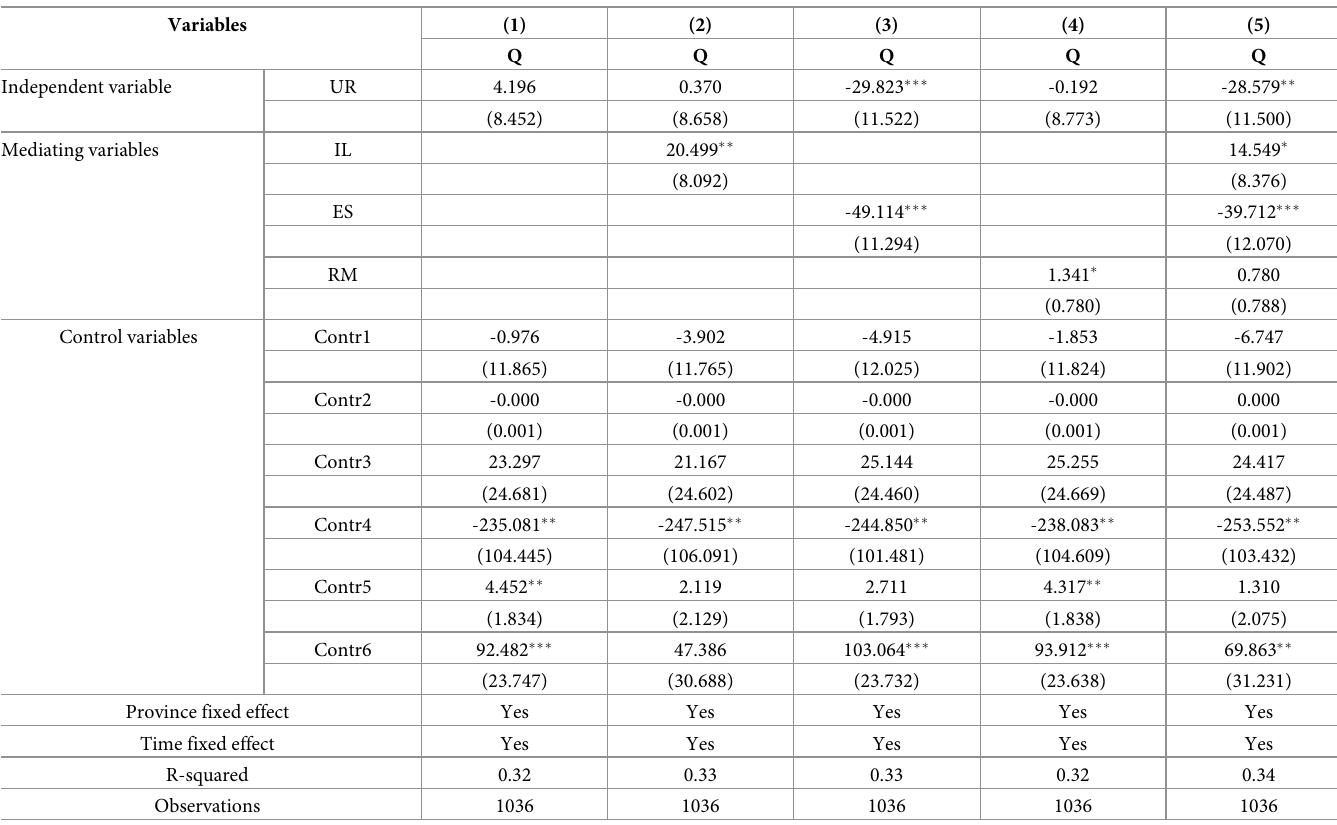
Table 3. Regression results of Model 1 and Model 3 a